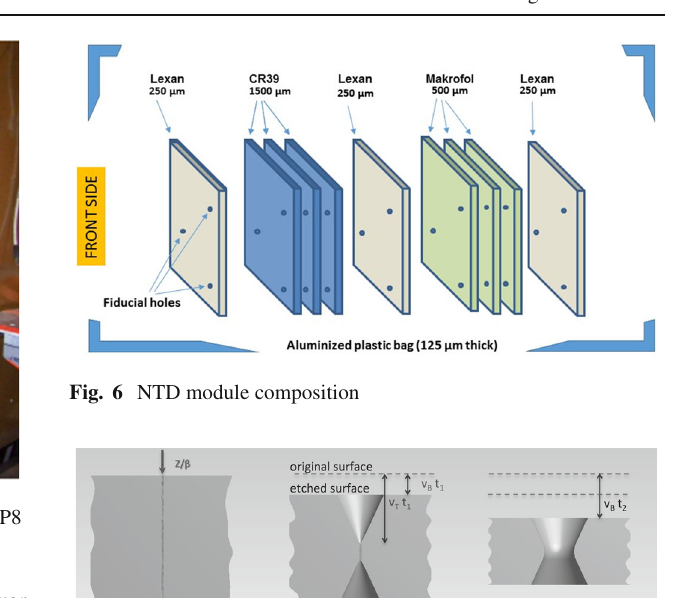
note that the MoEDAL detector is only subject to fields lower than ∼ 10 mT.